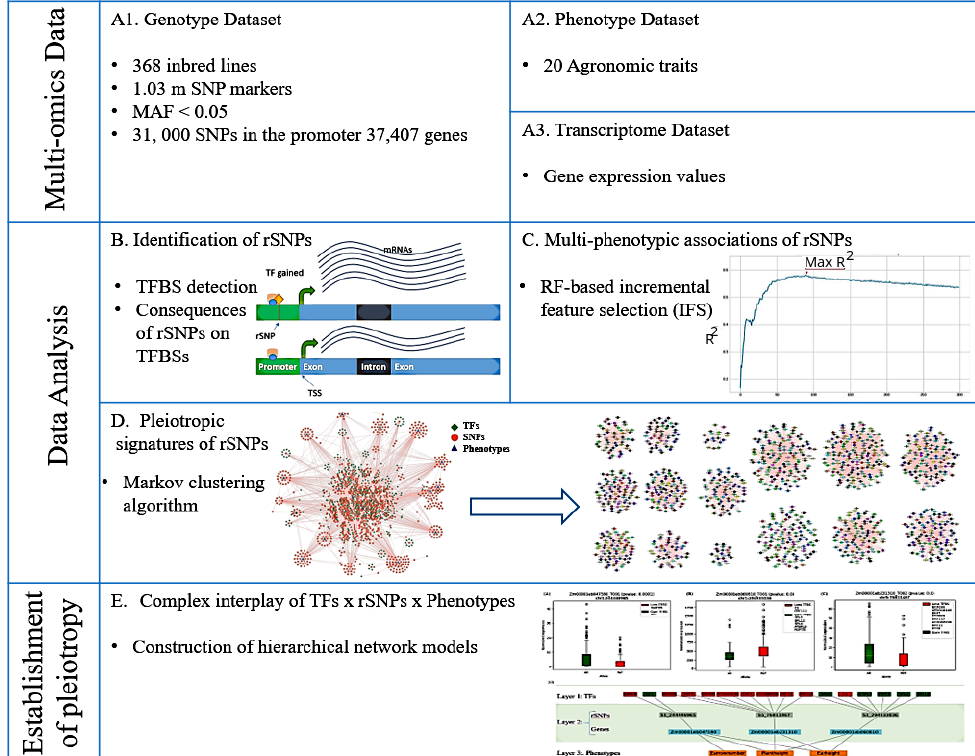
Figure 1. Overview of the analyses pipeline highlighting key machine learning algorithms for the identification of pleiotropic signatures of regulatory SNPs (rSNPs) to establish complex interplay of transcription factors (TFs), rSNPs and multiple phenotypes. The genotypic data ( A1 ), consisting